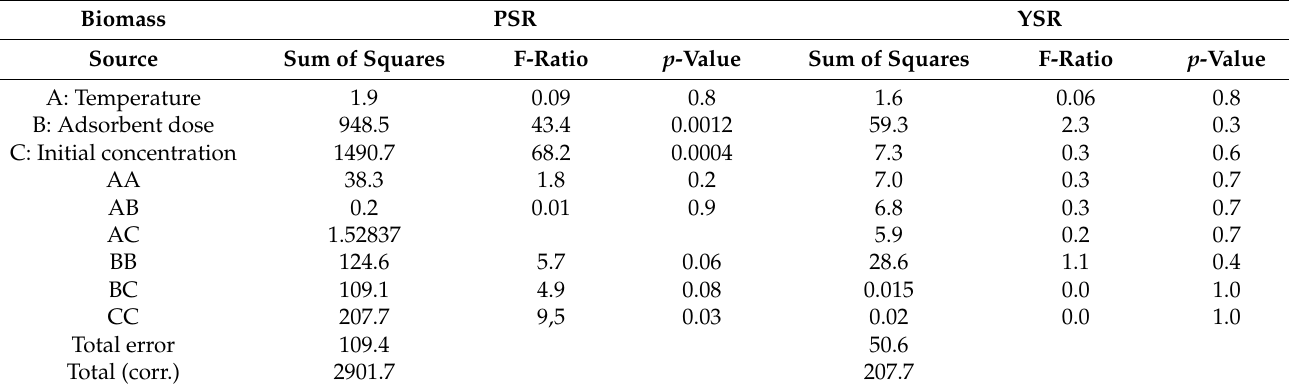
Table 6. Analysis of variance for Ni (II) adsorption in a batch